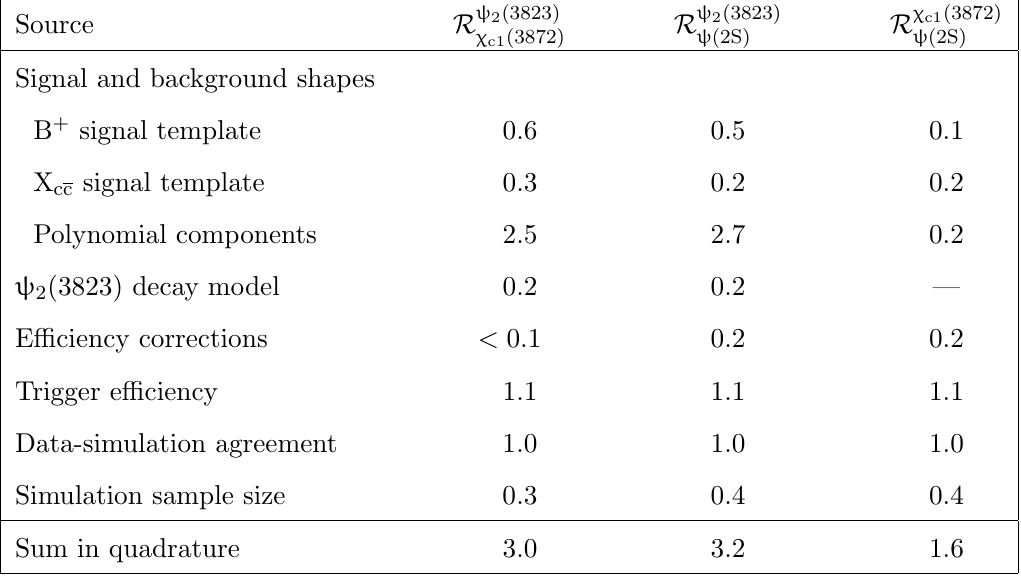
Table 2 . Relative systematic uncertainties (in %) for the ratios of branching fractions R X